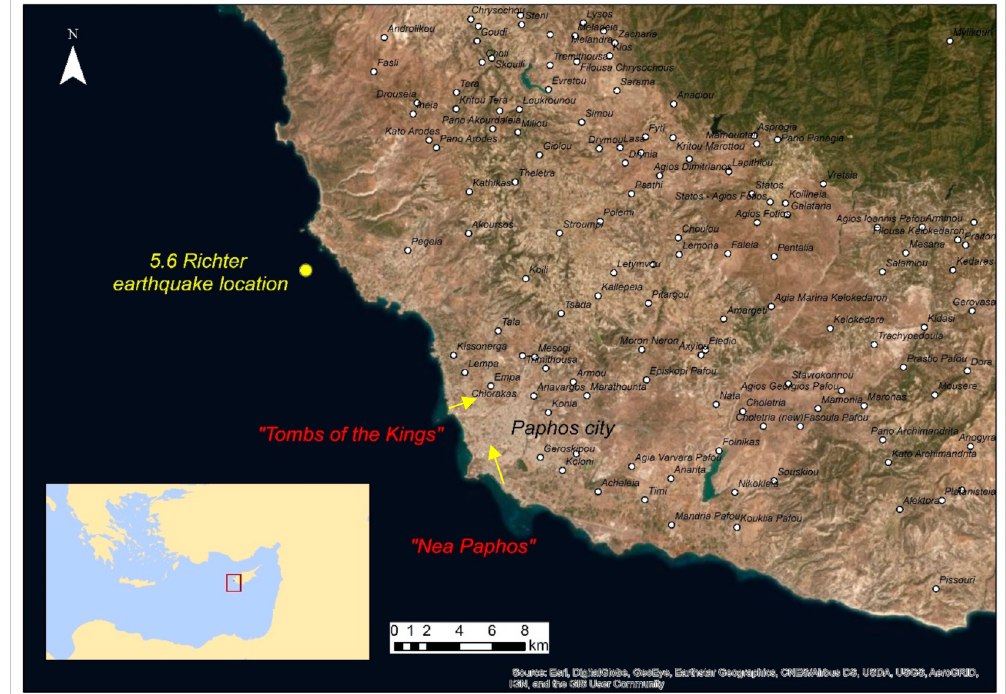
Figure 1. Map of Paphos and the epicenter of the 15 April 2015 earthquake.